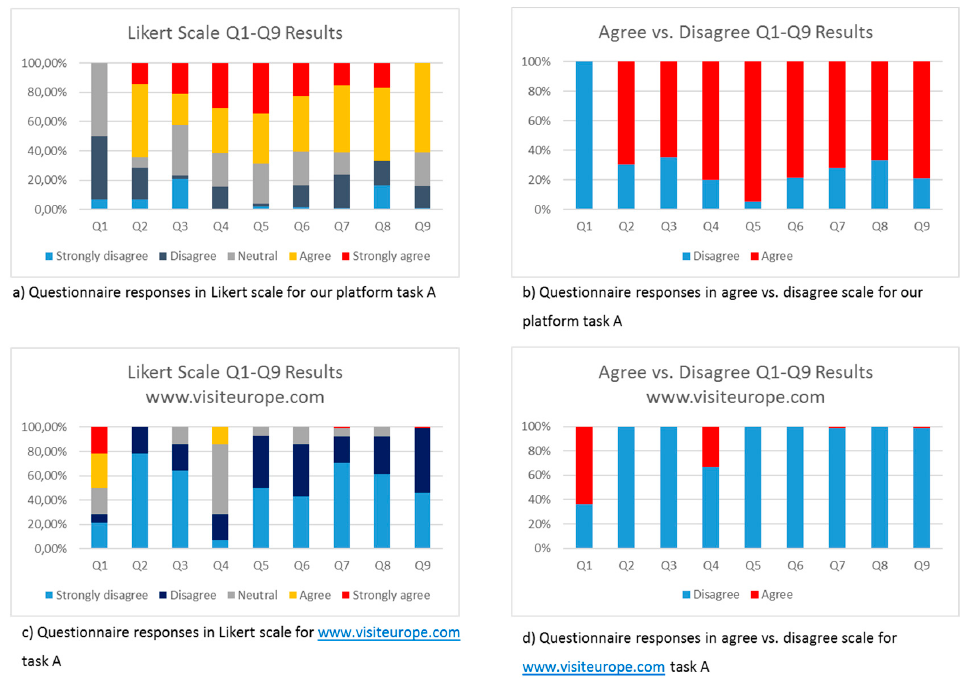
Figure 4. Results of the questionnaires in Likert and agree vs. disagree scales for IDAP ( a , b ) and www.visiteurope.com (accessed on 8 August 2021) platforms ( c , d ).